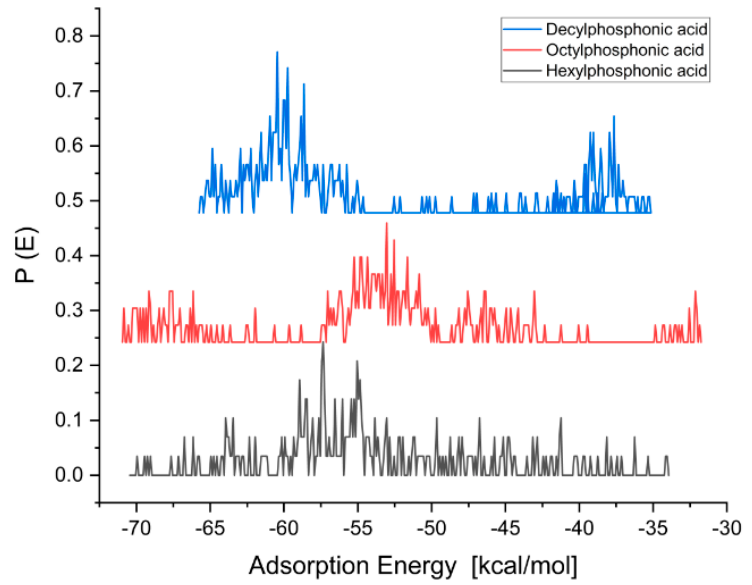
Figure 8. The adsorption energy of hexyl-, octyl- and decylphosphonic acids on the Cu (111) surface in aqueous medium.